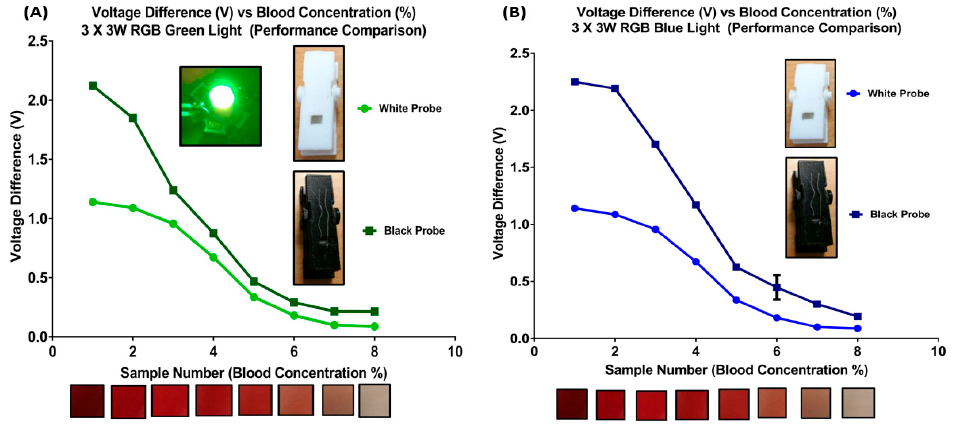
Figure 6. The performance of the black probe for both colors is better than that of the white probe, as shown in ( A ) and ( B ). The difference between each blood concentration measurement for the black probe is larger than the measurements by a white probe, indicating that each measurement of the black probe is much more specific and accurate than the white probe.